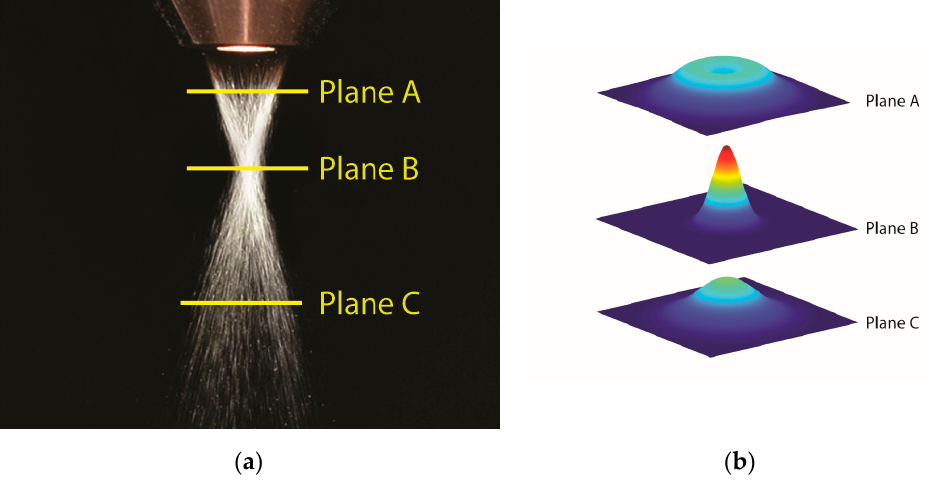
Figure 7. ( a ) Experimental and ( b ) numerical powder distribution evaluated at different planes be- low the nozzle exit (adapted from [53]).